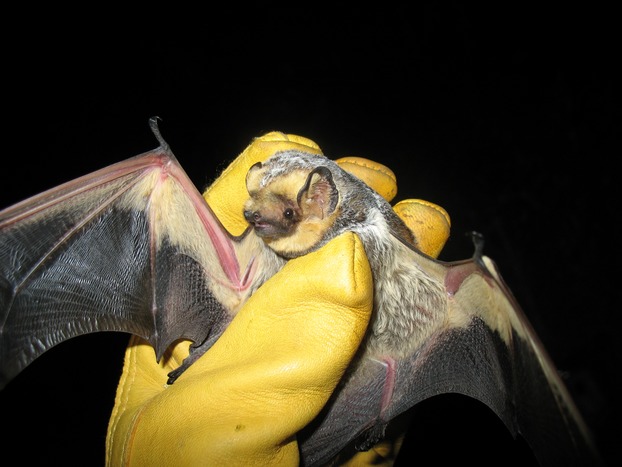
Hoary bat (Lasiurus cinereus), one of the species of bat to which miniature tracking tags were attached in this study. Photo credit P. Cryan.